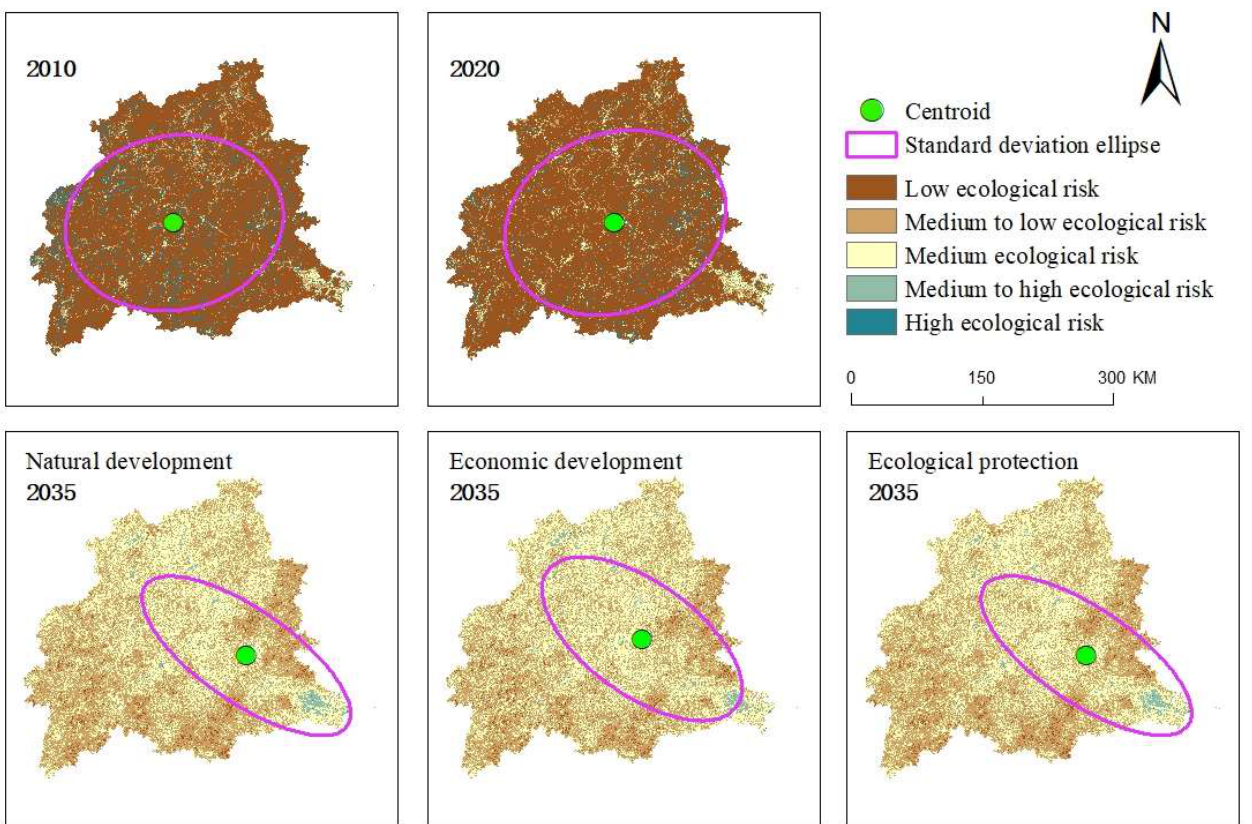
Figure 8. Adaptive ecological risk and elliptic spatial distribution of standard deviation.